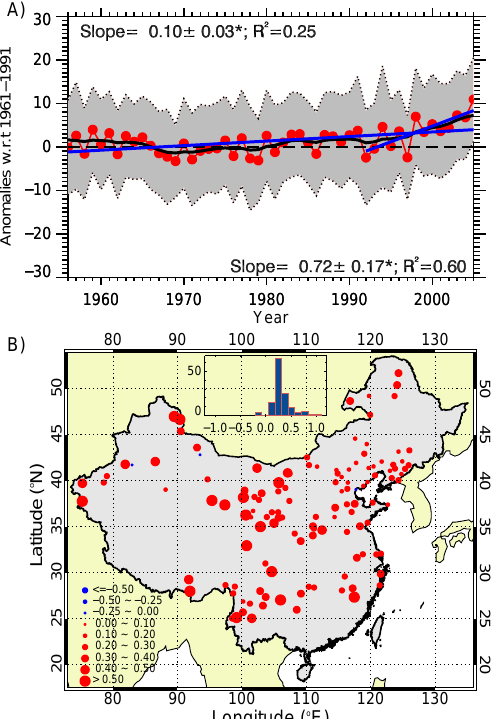
Figure 3. (a) Composite of anomalies for the first date (FD) from 1956 through 2006 across China. The composite of anomalies for FD was simply an average of anomaly across all available stations for each year. The solid circles represent the composite anomaly for a year. The shaded area represents 1 standard deviation from the mean for each year. The thick line represents a smoothed curve by a cut-off frequency of 0.091. The thick straight lines are linear regression trends. Asterisk indicates a statistically significant trend with a 95% or higher confidential level. (b) Rate of linear trends in FD from 1956 through 2006 for stations with 95% or higher confidential level across China; center-top panel is the histogram the rate of changes in FD.